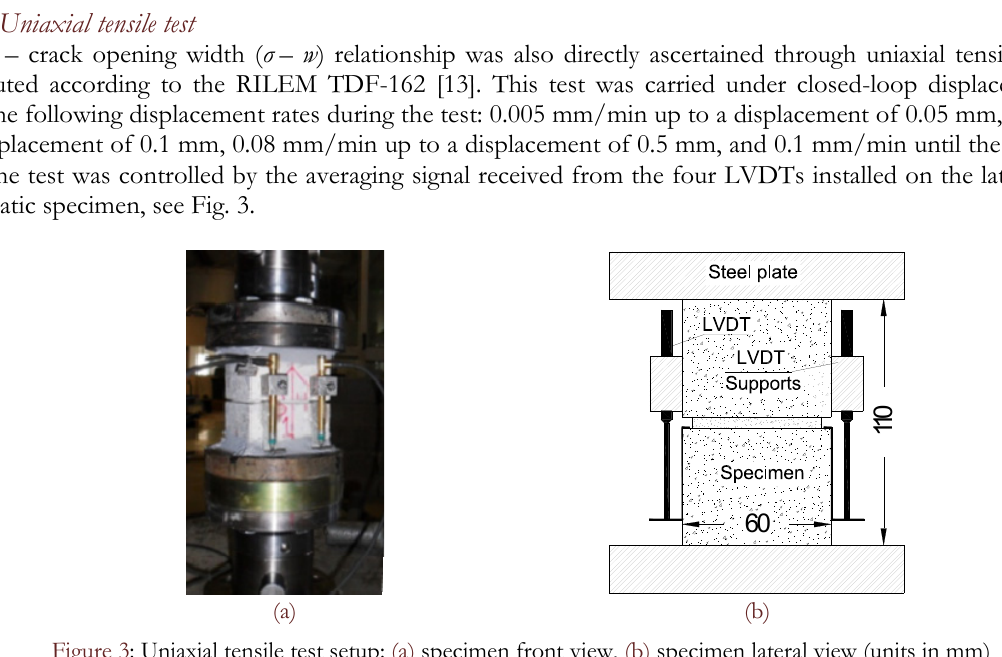
Figure 2: Geometry of the specimen and setup of the splitting tensile test (dimensions are in mm): (a) specimen front view (top of the panel), (b) specimen lateral view.